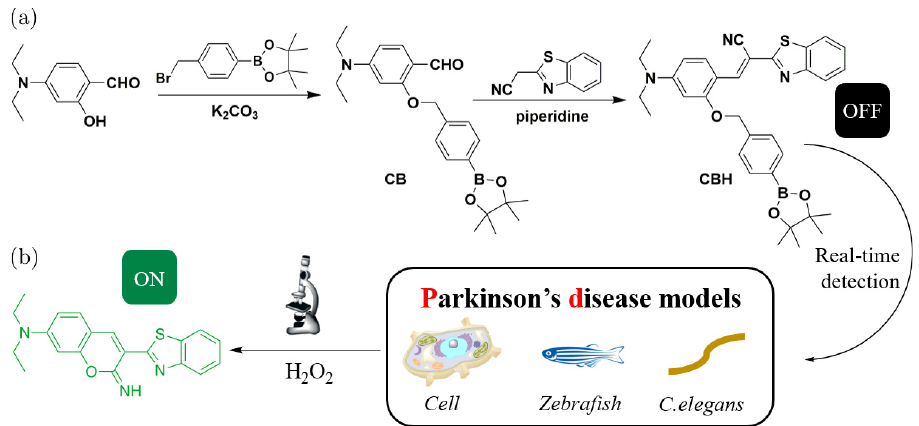
Scheme 1. (a) The design and synthesis route of the probe CBH; (b) Overall detection strategy by using probe CBH. The probe was used for bioimaging of H 2 O 2 in vitro , in living HeLa cells, zebra¯sh and C . elegans